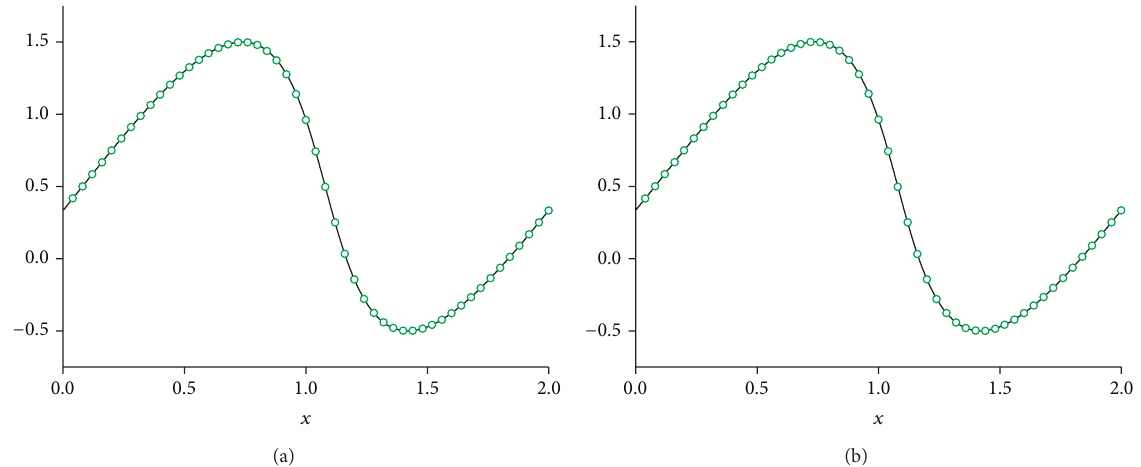
Figure 1: The numerical results of the Burgers equation at 𝑡 = 0.5/𝜋 with CFL = 5.9 , 𝑁 = 50 ; (a) M-SL-FV WENO 5 scheme; (b) M-C-SL-FD WENO 5 scheme; solid line: exact solution; circle: computed solution.